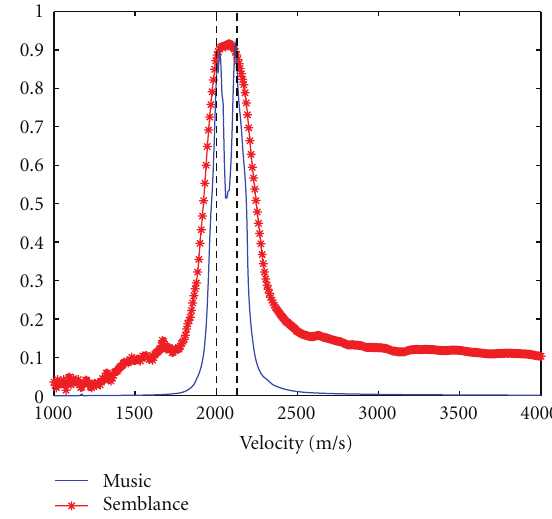
Figure 8: Parameter C determined using both MUSIC and semblance (point di ff ractor and a dipping reflector β = 20 0 ). The black dotted lines show the correct parameter